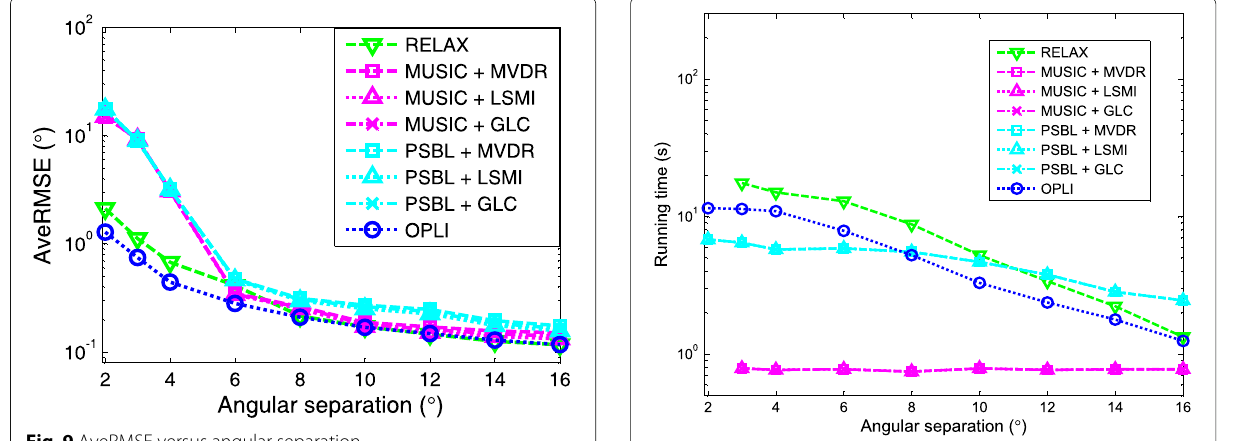
MATLAB 2013b running on a computer with a 2.3 GHz